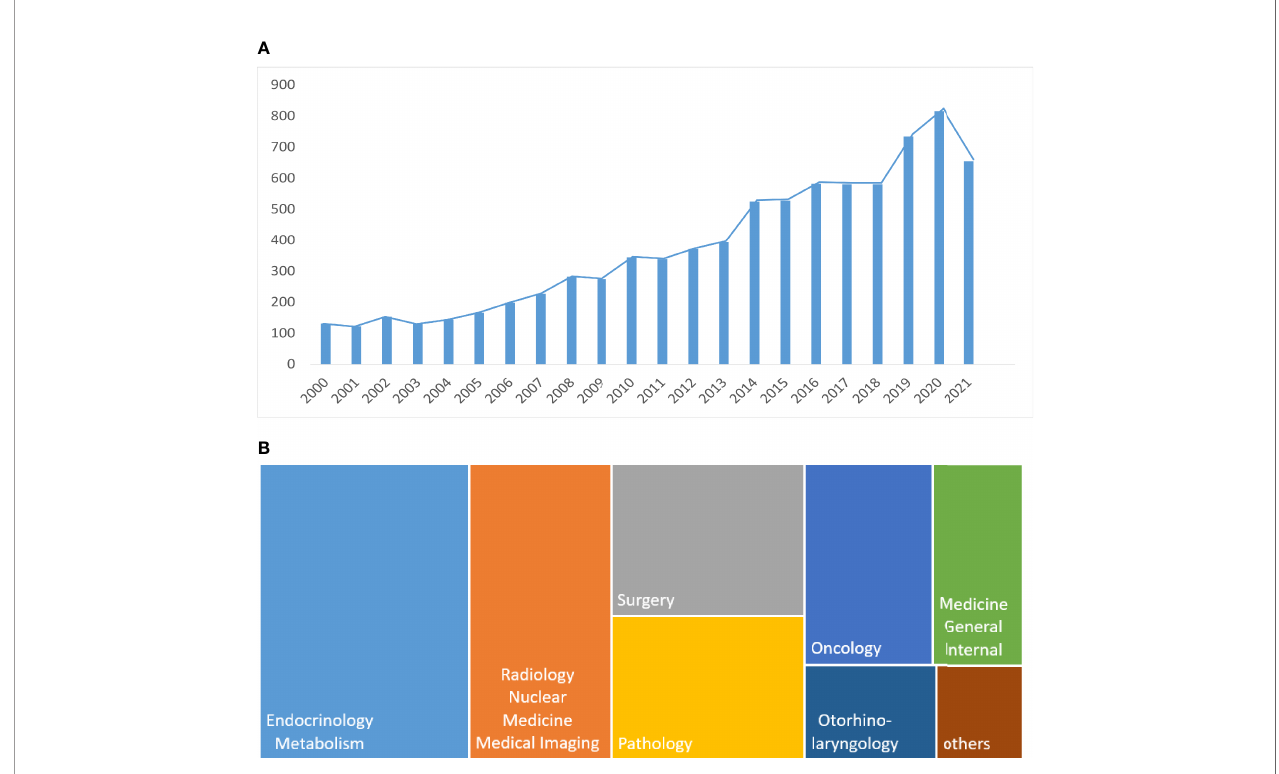
keywords, including elastography and benign features but also involved with fi ne-needle aspiration as a visual guidance. According to the ATA guidelines, some thyroid carcinomas with typical malignancy features can be diagnosed directly by ultrasound.